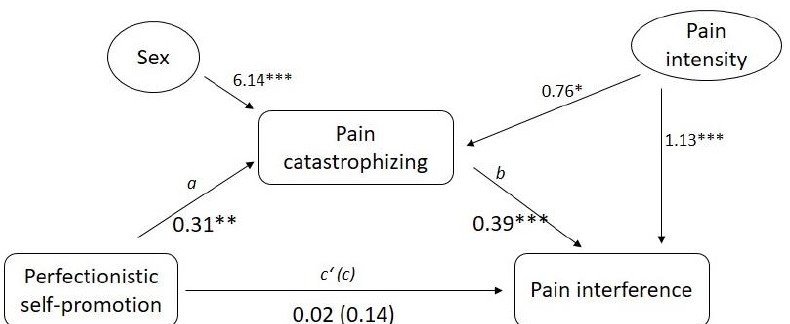
Figure 2. Mediation effects of pain catastrophizing on the association between perfectionistic self-promotion and pain interference. Note: * p < 0.05, ** p < 0.01, *** p < 0.001.